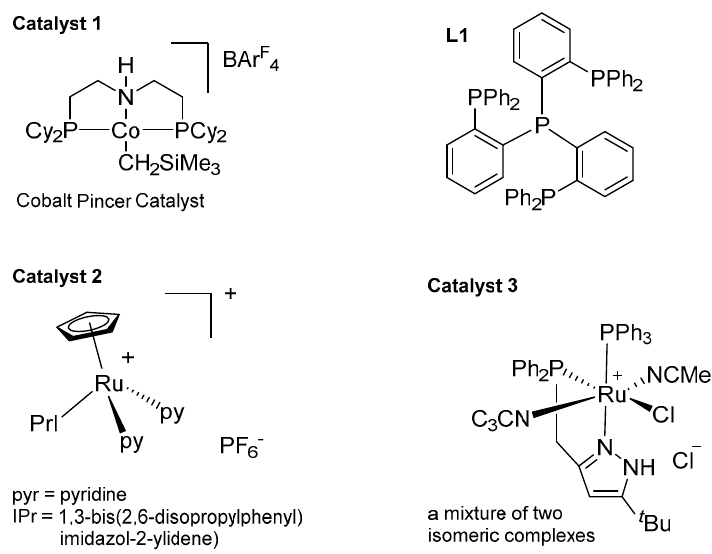
Figure 4. Catalyst and ligand structures.